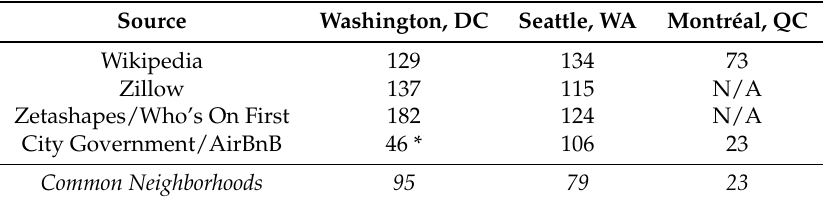
Table 2. Neighborhood names and boundary sources including polygon counts for each city. The * indicates that this source assigns many neighborhood names (comma delimited) to larger than average neighborhood regions. Note that Zillow and Zetashapes do not provide neighborhood names outside of the United States.